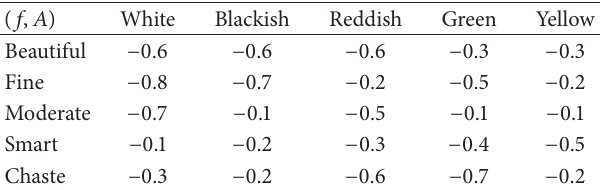
Table 8: Tabular representation of (𝑓, 𝐴) .